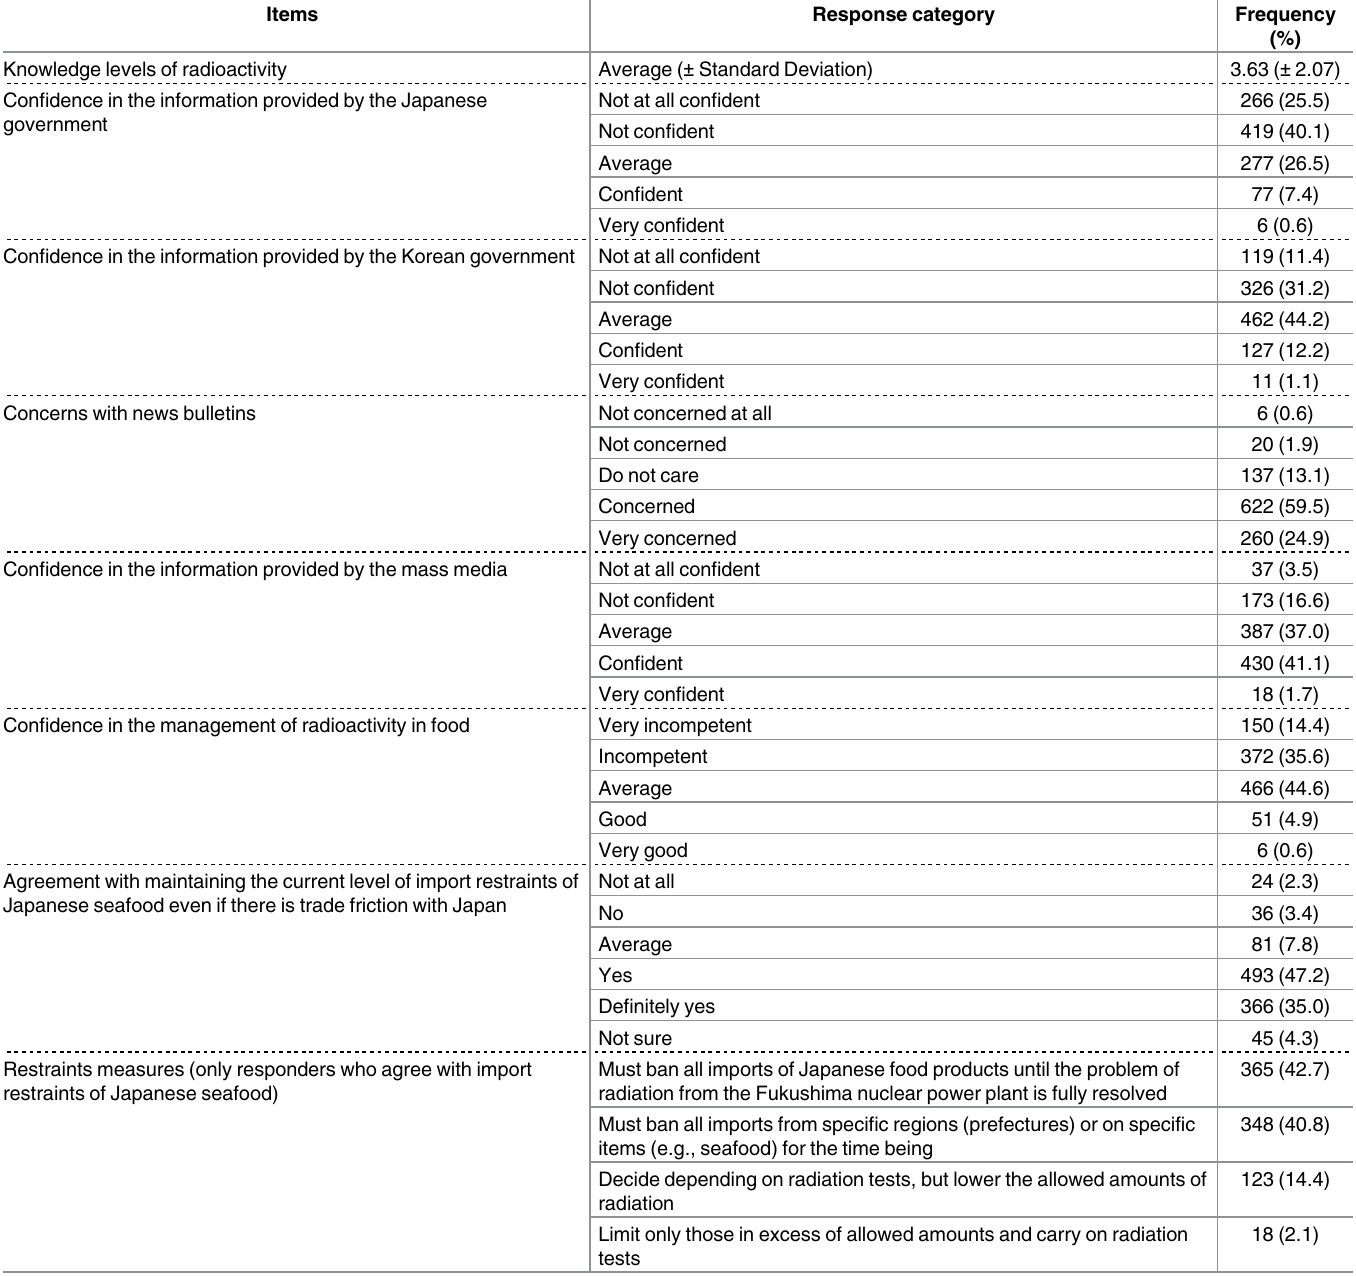
Table 4. Radiation knowledge and confidence in the governments’ food